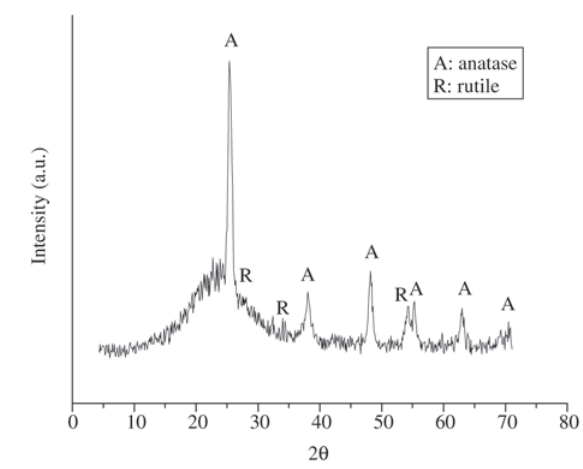
Figure 2. X ray diffraction peaks to STA sample.